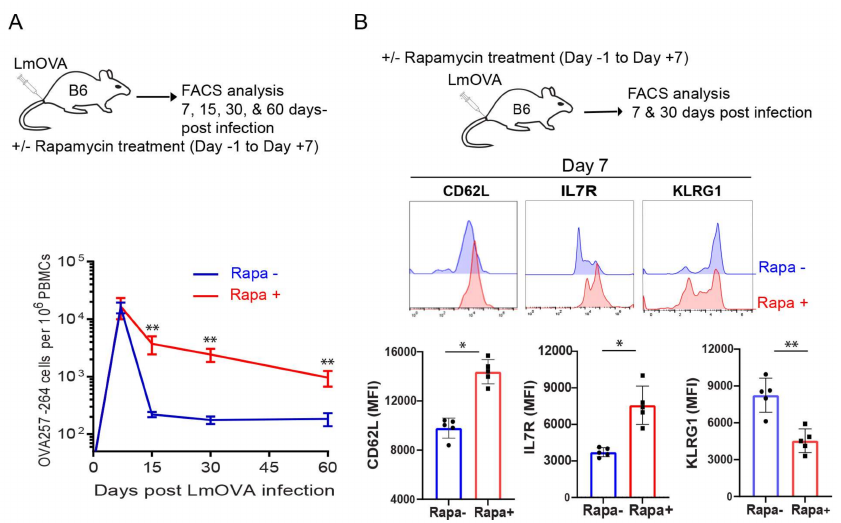
Figure 1. Rapamycin promotes in vivo CD8 + T-cell survival and memory formation. ( A ) Schematic diagram of rLmOVA infection in C57BL/6 mice. Mice ( n = 5/group) were intravenously injected on day 0 with 2000 CFUs of rLmOVA. Mice were treated with rapamycin from day − 1 to day +7. Rapamycin not treated mice received saline and served as controls. Longitudinally tracked kinetics of OVA-specific CD8 + T-cells in blood using flow cytometry. The line graph shows the frequencies of OVA-specific CD8 + T-cells in rapamycin-treated (red) and not treated (blue) groups. ( B ) Cell phenotype of the OVA-specific CD8 + T-cells in the peripheral blood was analyzed using cell surface memory markers by flow cytometry. Data presented as means ± SEM are representative of two independent experiments with similar results ( n = 2–3/group/experiment). * p < 0.05, ** p < 0.01 by two-tailed Student’s t